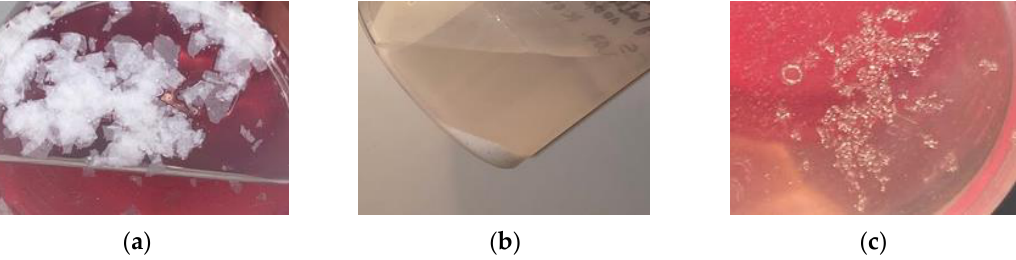
Figure 4. Representative samples with some visible effects on the surface compared to the unaged one. ( a ) reference (I), ( b ) weathering (II)—red arrow shows the place of attachment, which was covered from the sun radiation, ( c ) alkalis at 20 °C (V), ( d ) tap water (VIII), ( e ) frozen water (IX) .